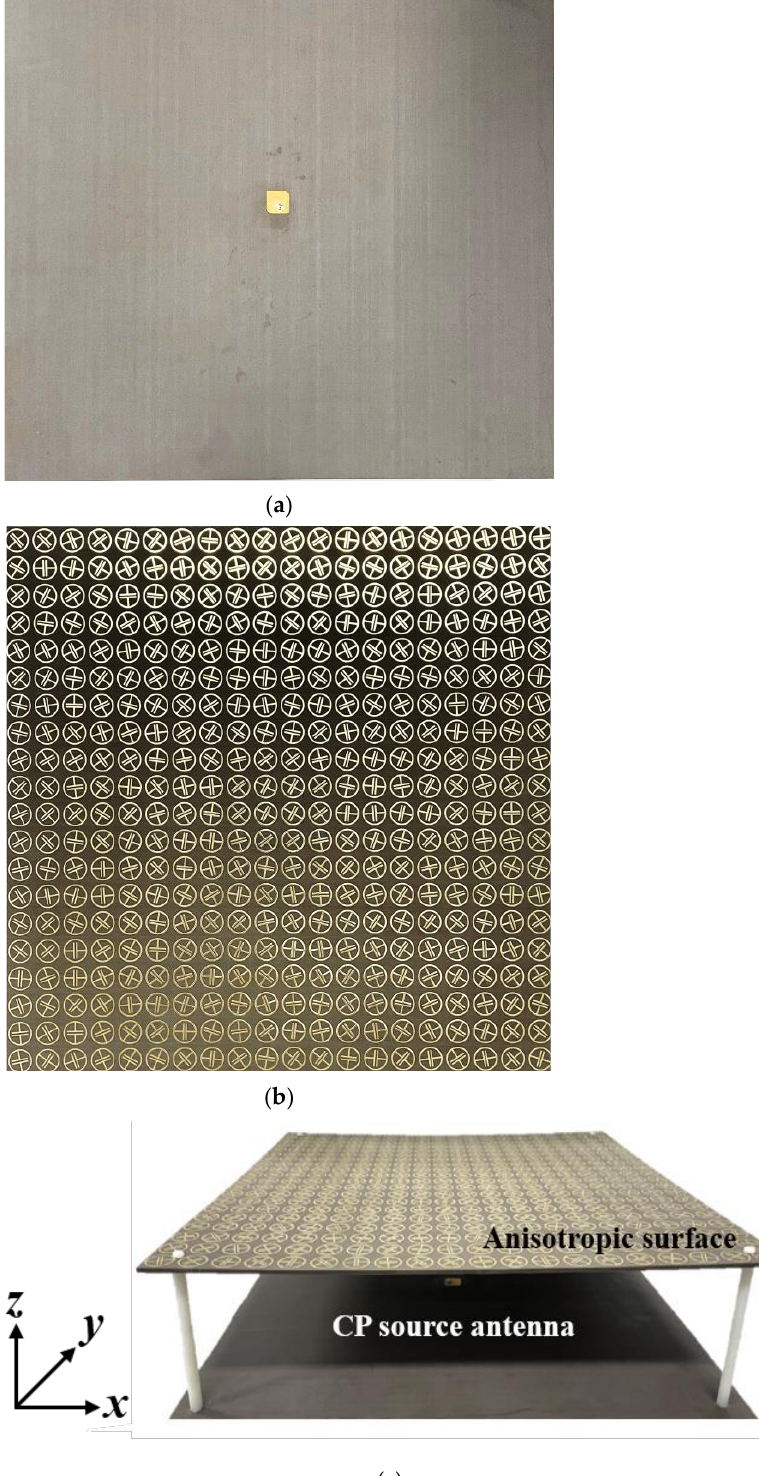
Figure 5. Photographs of fabricated transmitarray antenna. ( a ) source antenna ( b ) Anisotropic antenna ( c ) Transmitarray antenna.